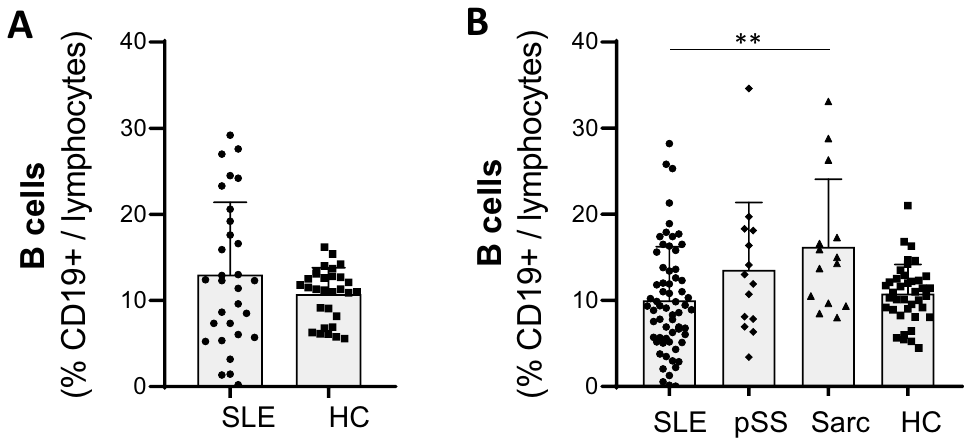
Figure 1. Frequency of B cells (CD19 + ) in systemic lupus erythematosus (SLE) patients compared to controls in two separate cohorts. ( A ) Frequency of B cells in SLE patients compared to healthy controls (HC): B cell analysis by mass cytometry followed by manual gating in 30 SLE and 30 HC (cohort A). ( B ) Frequency of B cells in SLE patients compared to other autoimmune diseases and HC: B cell analysis by flow cytometry in fresh blood of 63 SLE patients, 14 primary Sjögren’s syndrome, 14 sarcoidosis and 39 HC (cohort B). Bar plots represents mean ± SD. Statistical analysis were performed on log-transformed data (to obtain normal distributions) using a student-t-test ( A ) or a one-way ANOVA followed by Bonferroni’s correction ( B ), p value* < 0.05, p value ** < 0.01, p value *** < 0.001. Analylsis and figures were performed using GraphPad Prism version 8.0.0 for Windows (GraphPad Software, San Diego, California USA, www. graph pad.